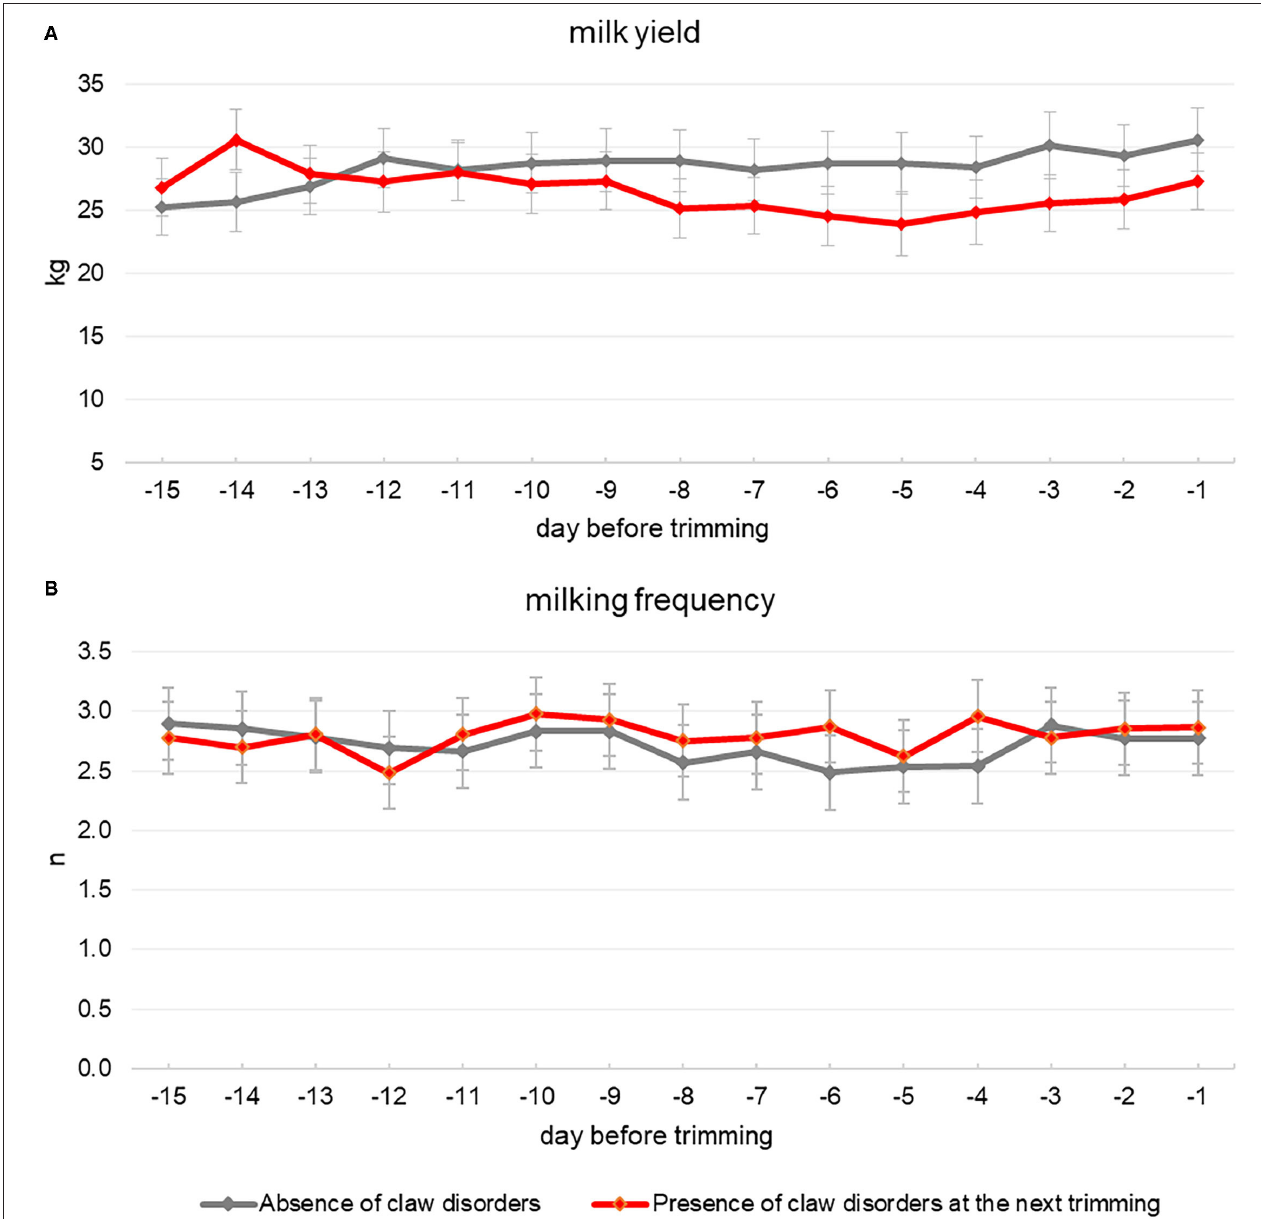
FIGURE 2 | Daily milk yield (A) and milking frequency (B) patterns of 15 Italian Holstein multiparous cows over the 15 days that preceded two following hoof trimming practices in which they were diagnosed with no claw disorders (gray line) or affected by claw disorders (red line),